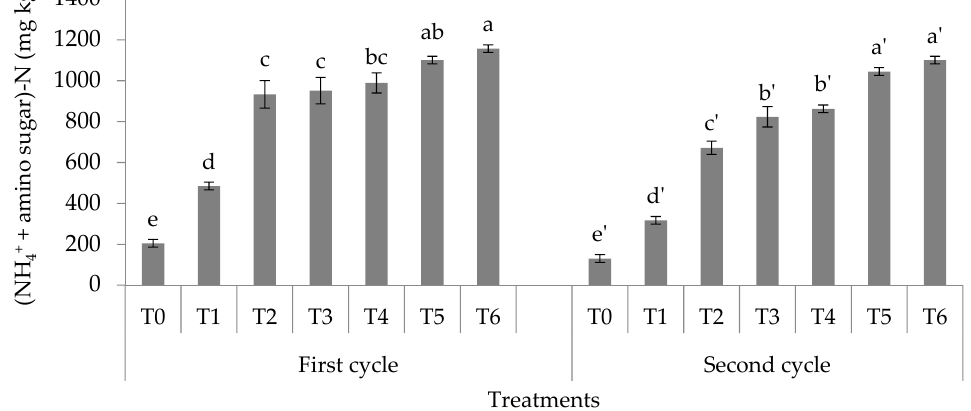
Figure 3. Effects of treatments on soil total hydrolyzable ammonium. Means with the same letter above the bars within a crop cycle are not significantly different at p ≤ 0.05. Bars represent the mean values ± standard error .